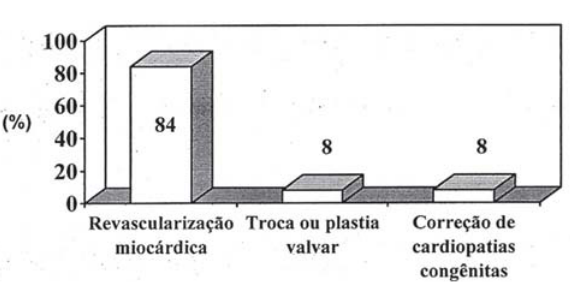
Fig. 2 - Distribuição dos casos de mediastinite por tipo de cirurgia